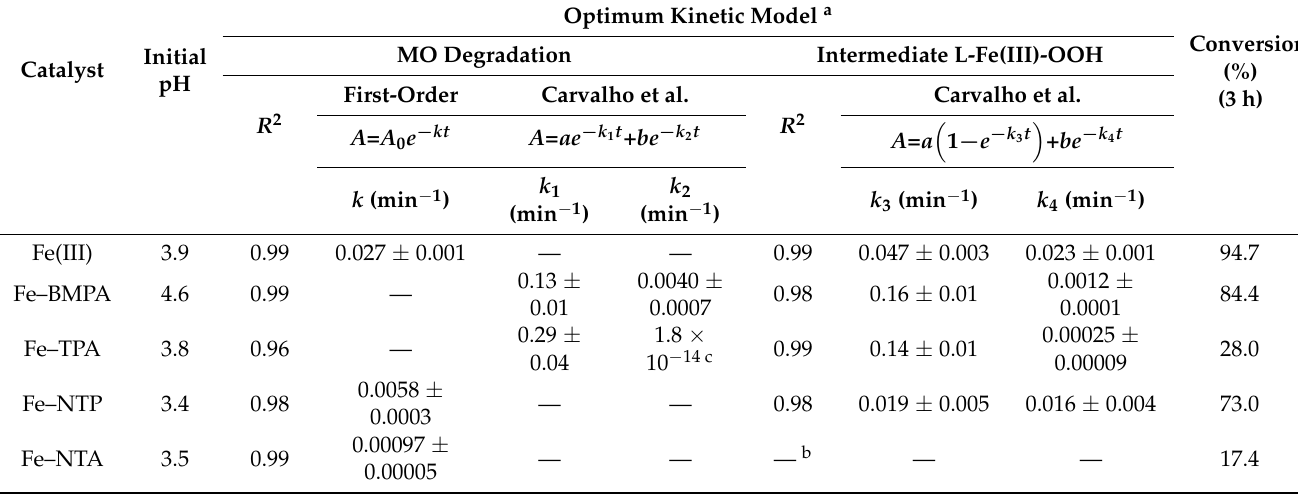
Table 1. Adjusted kinetic parameters ( ± SD) for the MO oxidative degradation by H 2 O 2